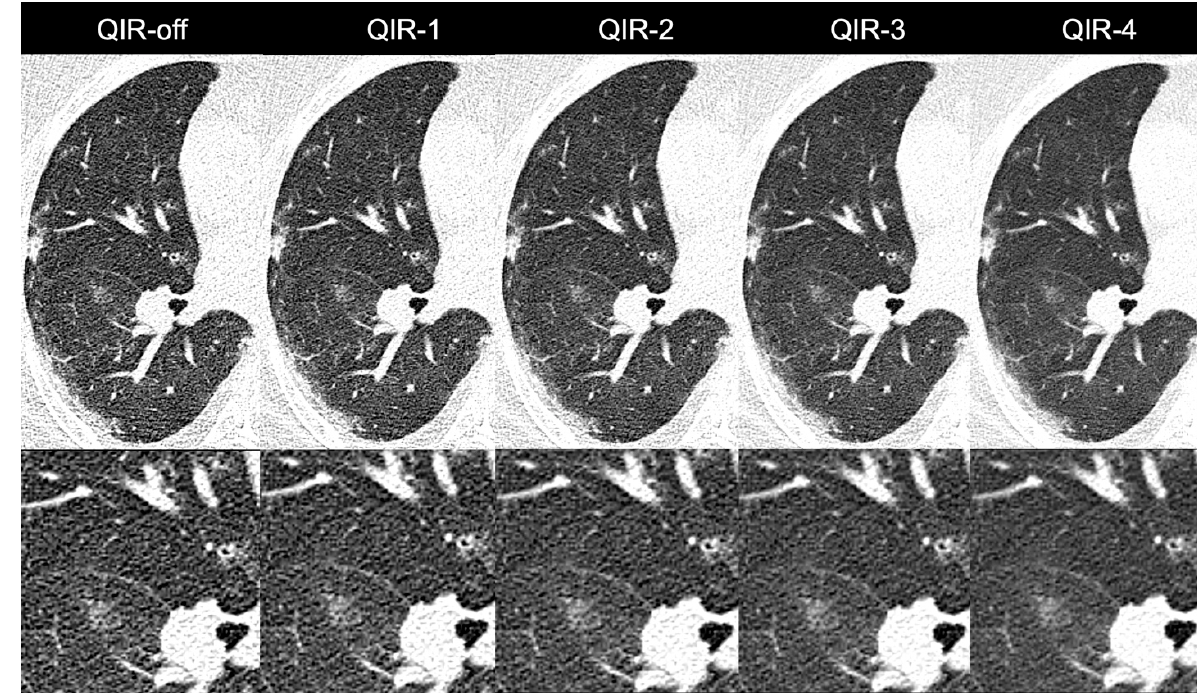
Figure 5. Images of a 55-year-old female patient with atypical pneumonia. Noise was reduced considerably when changing from QIR-off to higher levels of QIR. Note the slightly smoother appearance of QIR-4 as opposed to lower levels of QIR indicating slightly reduced sharpness.